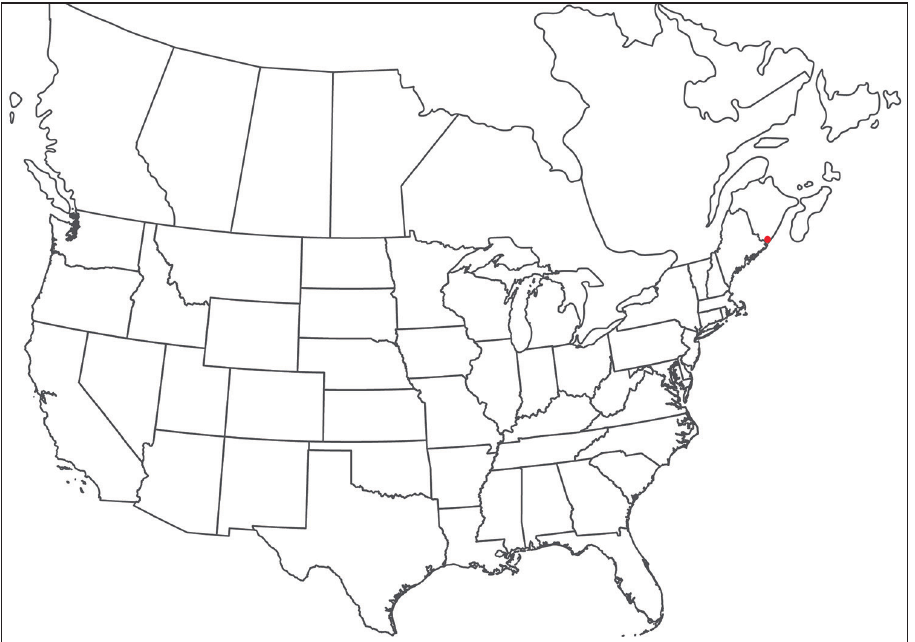
Figure 70. Torrenticola elusiva sp. n.